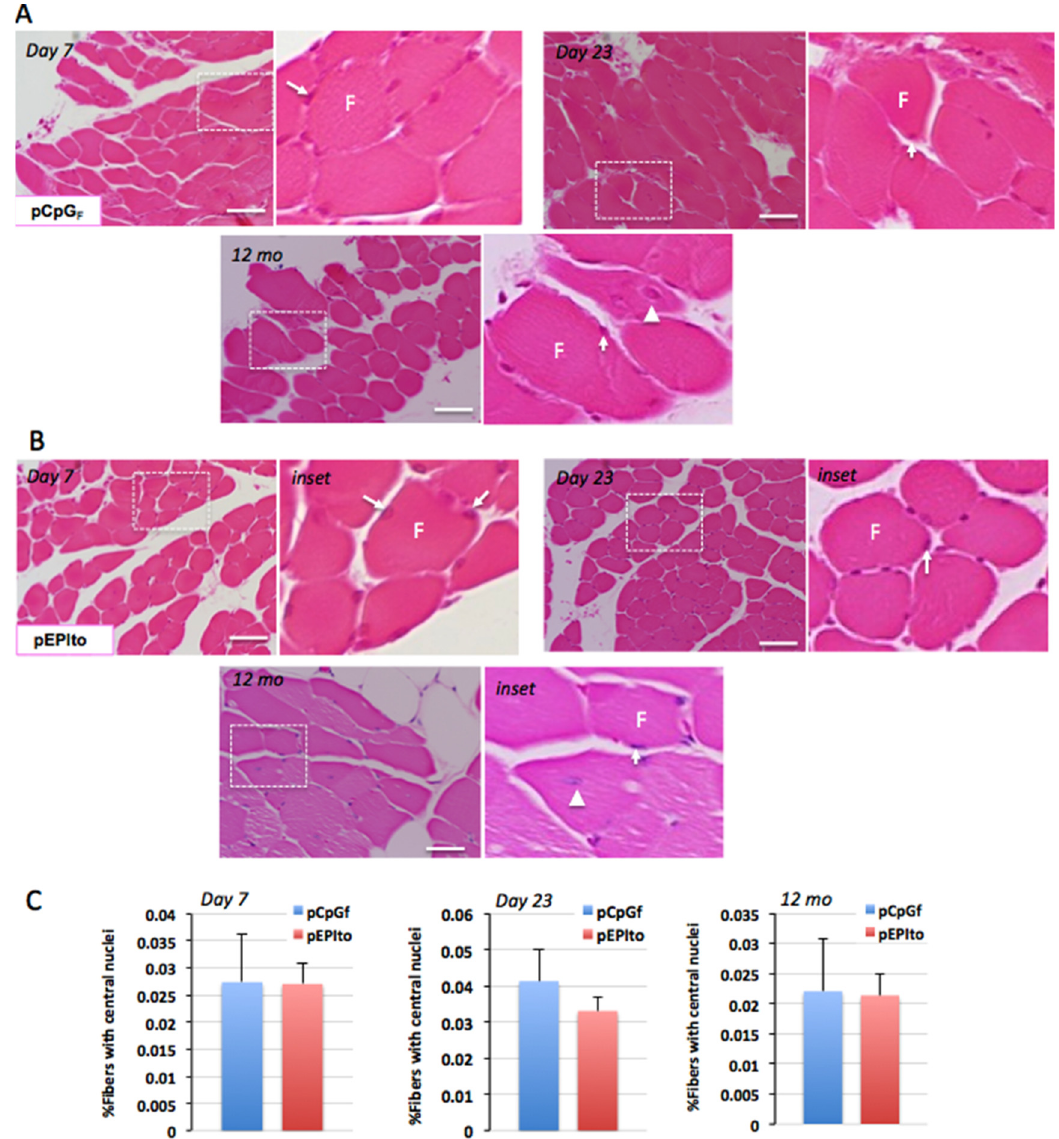
Figure 4. Histological analyses at day 7, 23, and 12 months indicate neither pCpG F ( A ) nor pEPIto ( B ) produce any significant signs of damage, as shown by H&E staining and visualization of skeletal muscle at 200x magnification. Inset, selected areas at higher magnification to show nuclear positioning in muscle fibers. Scale bar, 50 μ m. Arrows, normal positioning of nuclei at the periphery of muscle fibers (F); arrowheads, occasional atypical nuclei positioned centrally within fibers. ( C ) Analyses of percentage of muscle fibers displaying atypical central nuclei show no significant differences ( p > 0.3) for either plasmid group for all three time